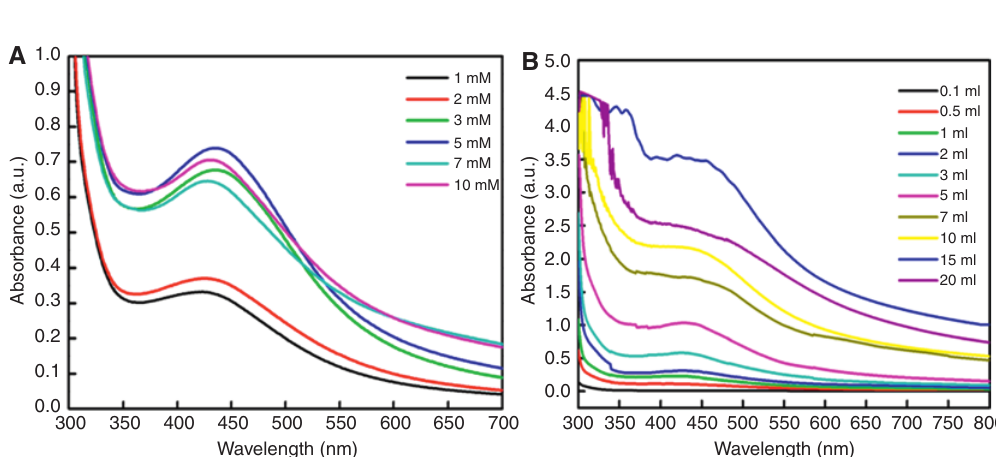
Figure 1: UV-vis spectra of as-synthesized silver nanoparticles (AgNPs) as a function of (A) varying AgNO concentration in 25 ml total